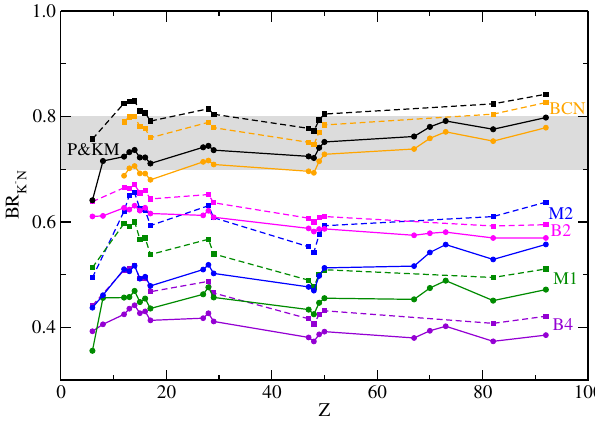
Figure 2. K − single-nucleon absorption fraction, BR K − N , calculated for lower (solid lines) and upper (dashed lines) atomic levels using the state-of-the-art chiral models as a function of the proton number Z. The gray band denotes the experimental value including the error bar deduced from bubble chamber experiments